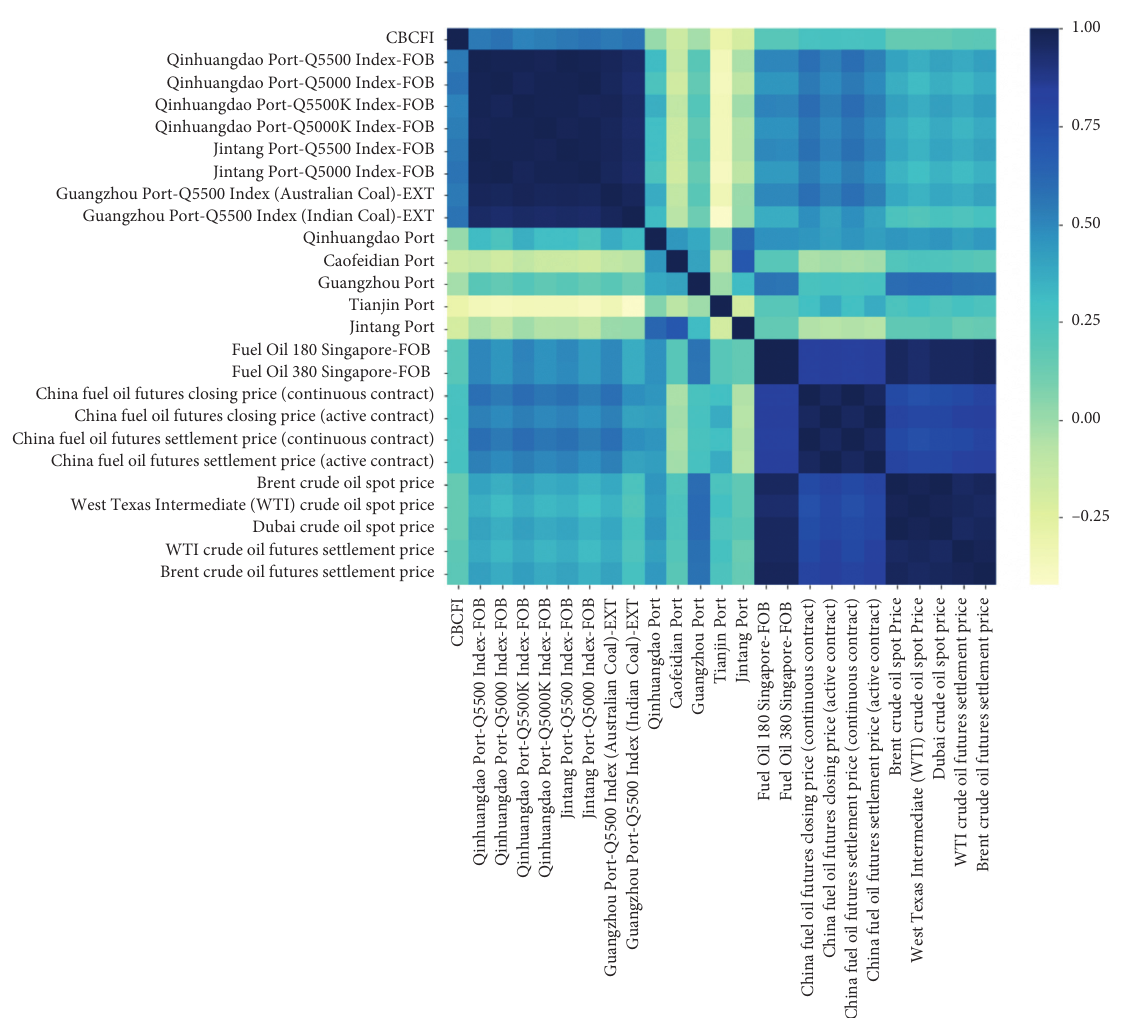
Figure 3: The Pearson correlation matrix of all